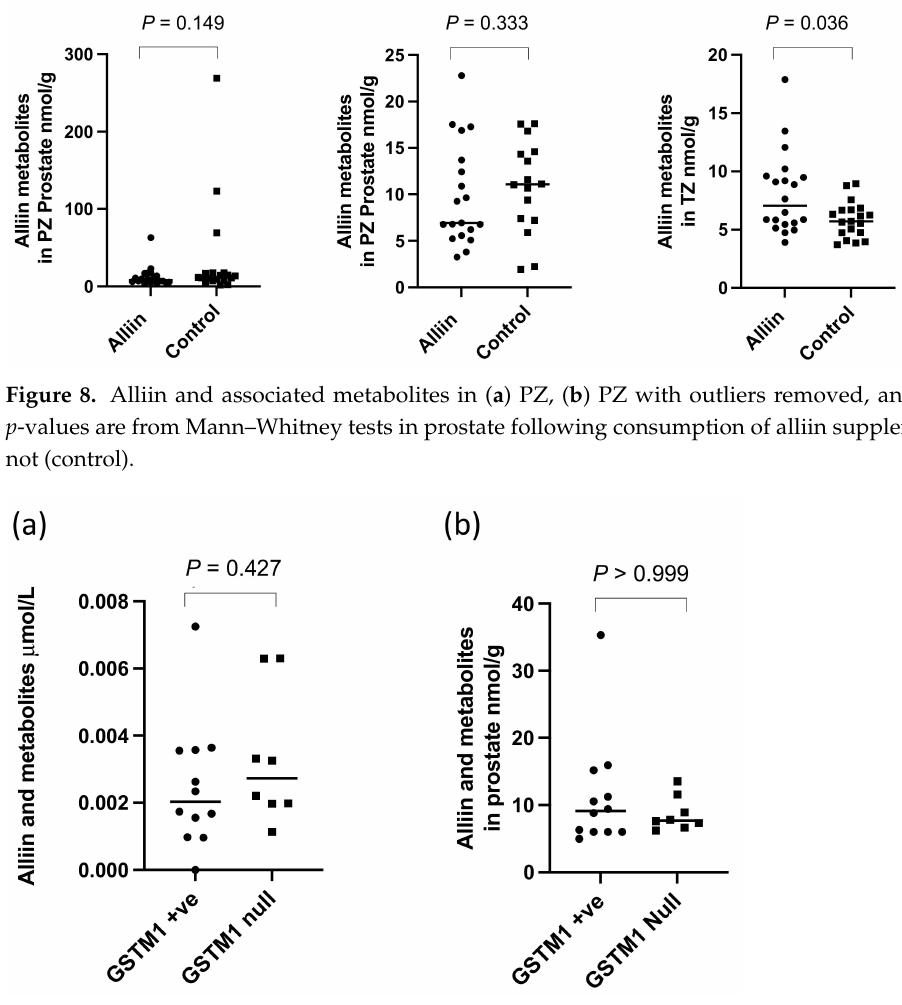
Figure 9. Alliin in metabolites in ( a ) urine and ( b ) prostate of GSTM1 +ve and null participants who consumed the alliin supplement. p -values are from Mann–Whitney